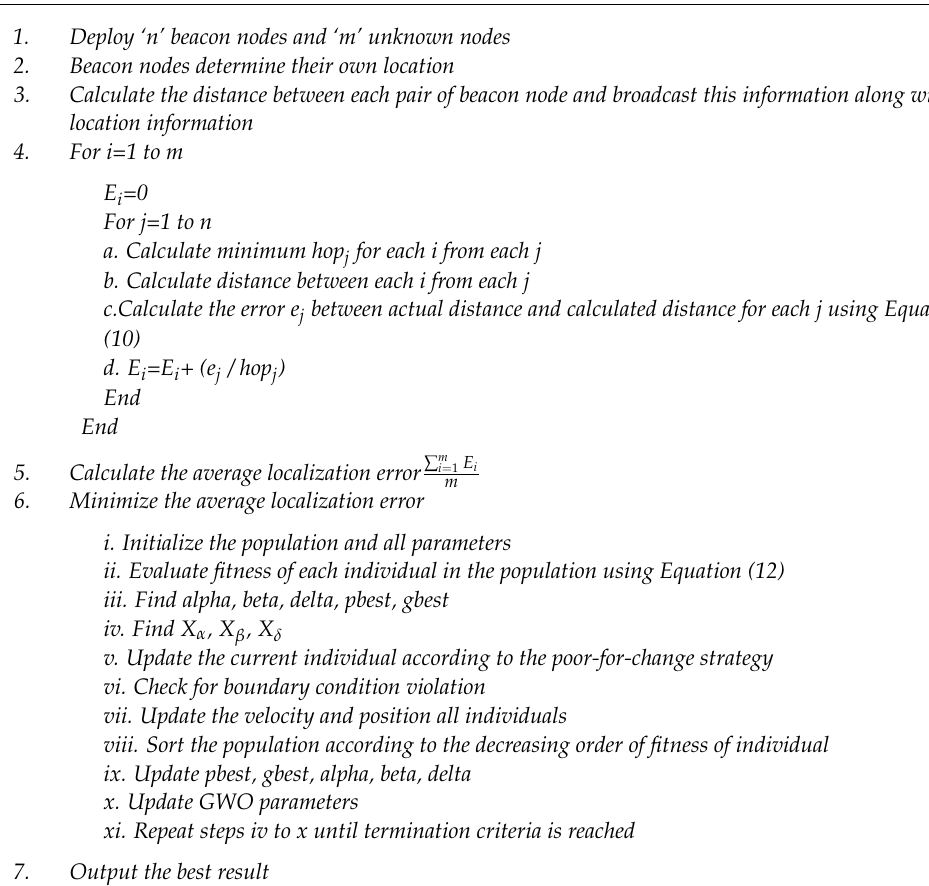
Algorithm 3 : Hybrid DV-Hop-PSO-GWO algorithm for node